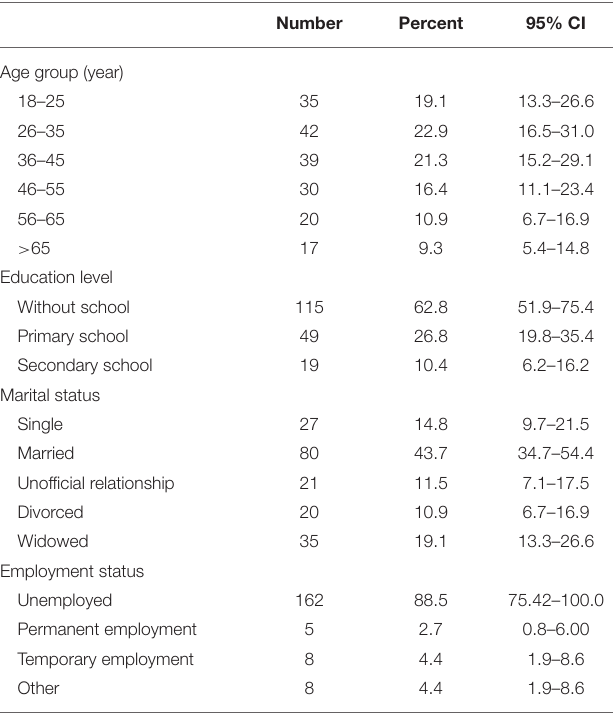
TABLE 1 | Sociodemographic characteristic of the sample of Bosnian Roma women ( n = 183).